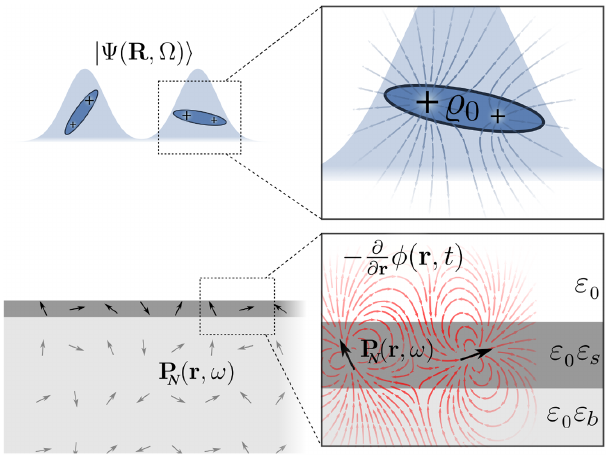
FIG. 1. A charged particle (blue) with charge distribution (cid:3) 0 evolving in a spatio-orientational superposition state | (cid:9)( R , (cid:2)) (cid:5) will suffer from motional decoherence due to electric fields (red lines) originating from a fluctuating polarization (black arrows) in nearby metallic or dielectric surfaces. The fluctuation strength of the polarization at a position r depends on the dielectric material response ε 0 ε r ( r , ω) and the temperature T . For small distances, the electric field propagates quasistatically from each fluctuation to the particle, as can be described by a scalar poten- tial φ( r , t ) . A layered dielectric consisting of a surface layer with ε (ω) and a bulk dielectric with ε ε (ω) can explain the noise ε 0 0 s b levels and scalings measured in ion traps